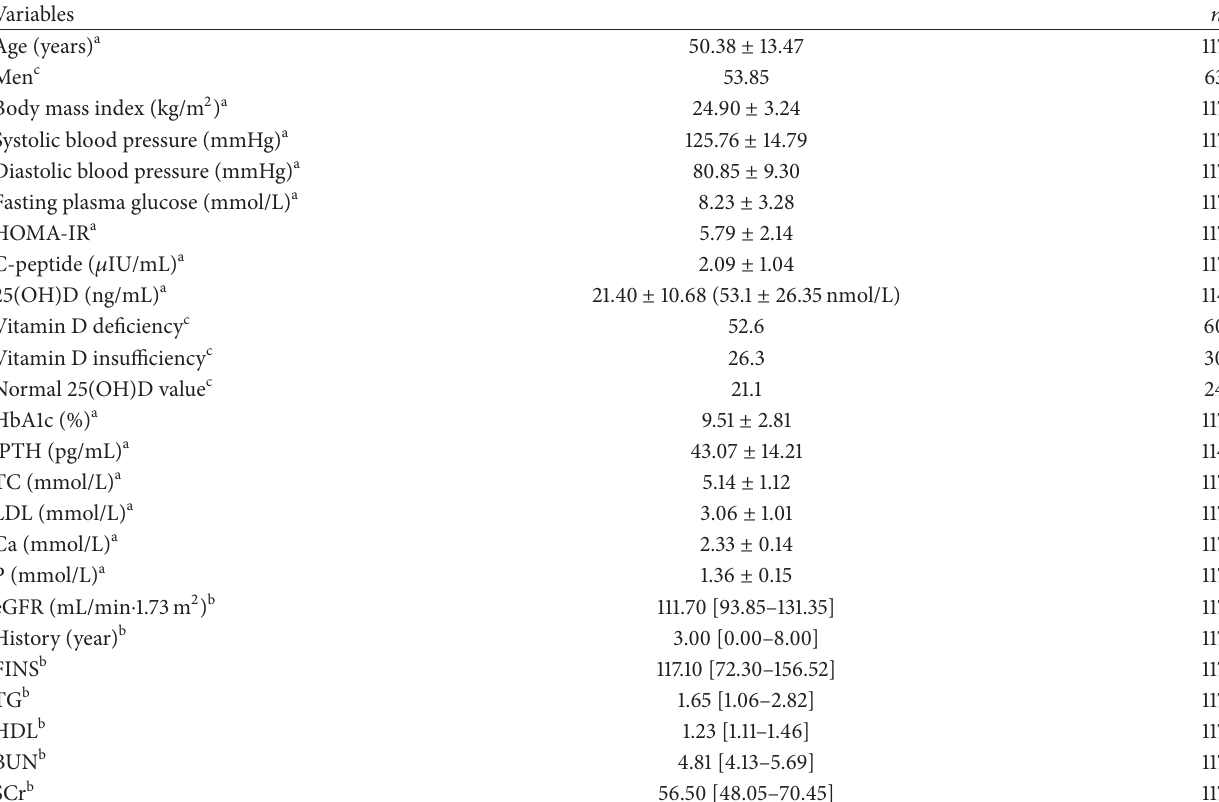
Table 1: Characteristics of the study